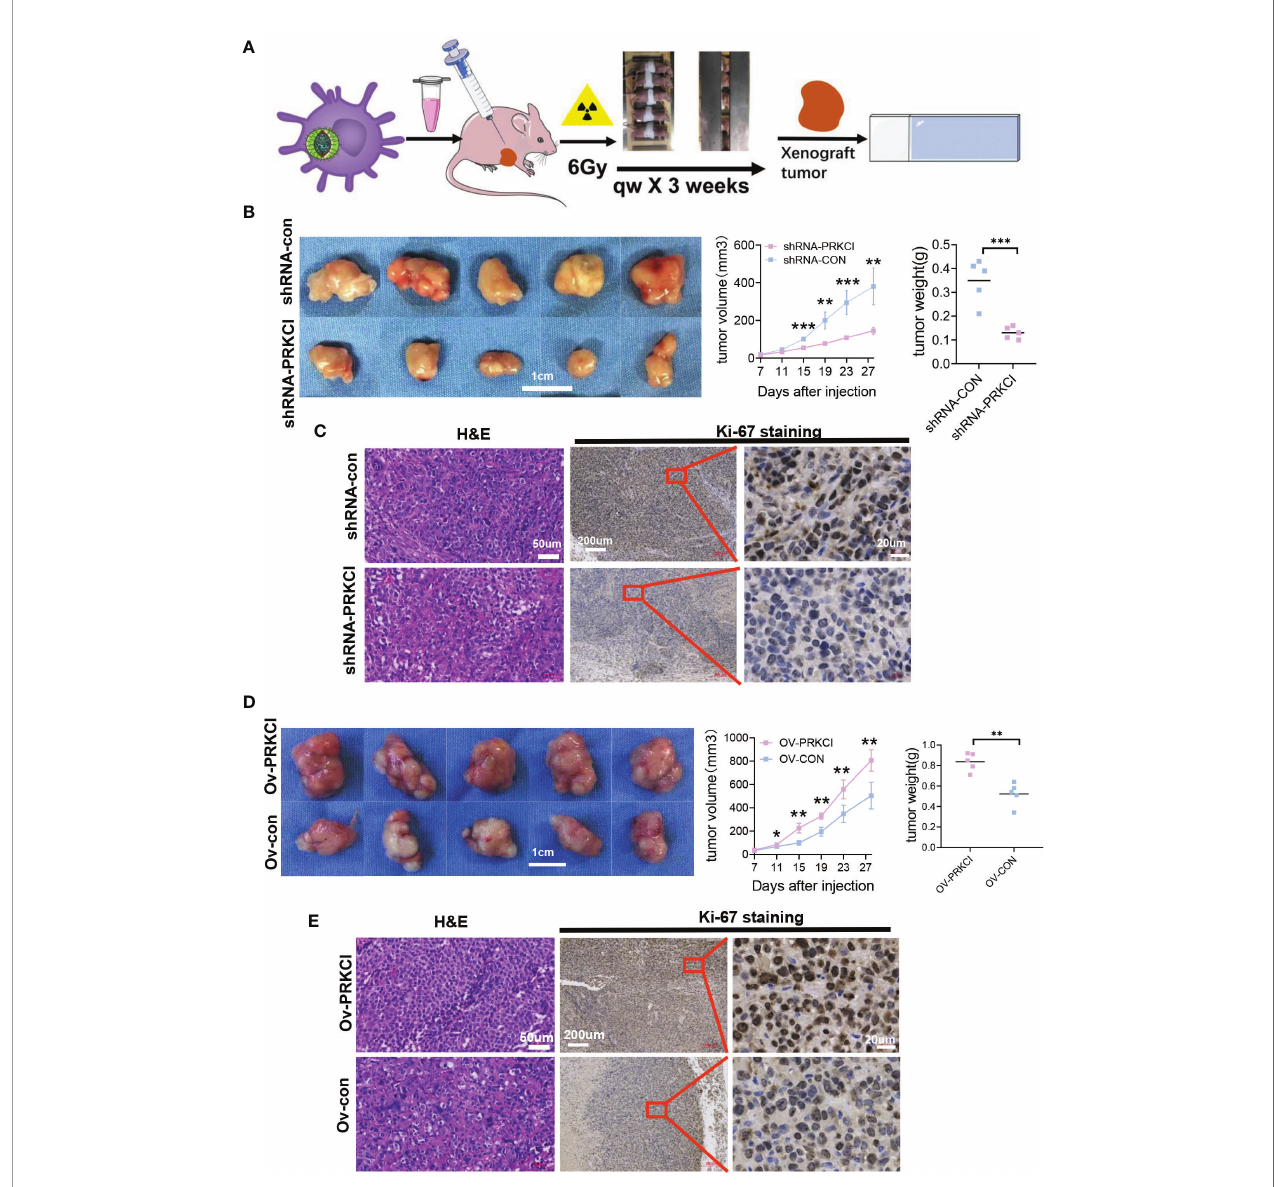
FIGURE 4 | In fl uence of PRKCI suppression and overexpression on radiosensitivity in CC cells in vivo . (A) Work fl ow for nude mice with xenografts treated with 6 Gy/qw radiation for 3 weeks. (B) Nude mice with SiHa-shRNA-PRKCI and SiHa-shRNA-con were treated with radiation. The xenograft weights and volumes were measured (n = 5/group). (C) Representative images of H&E (×100) and Ki-67 (×50, ×400) staining of the xenografts. Ki-67 staining showed that PRKCI knockdown decreased proliferation. (D) Nude mouse models treated with SiHa-ov-PRKCI and SiHa-ov-con were presented and were treated with radiation. The xenograft weights and volumes were measured (n = 5/group). (E) Representative images of H&E (×100) and Ki-67 (×50, ×400) staining of the xenografts. Ki-67 staining showed that PRKCI overexpression increased proliferation. Scale bars are shown. Data are shown as the mean (n = 5). *p < 0.05; **p < 0.01; ***p < 0.001 by unpaired t-tests (B, C, D) , by multiple t-tests (B, D) . CC, cervical